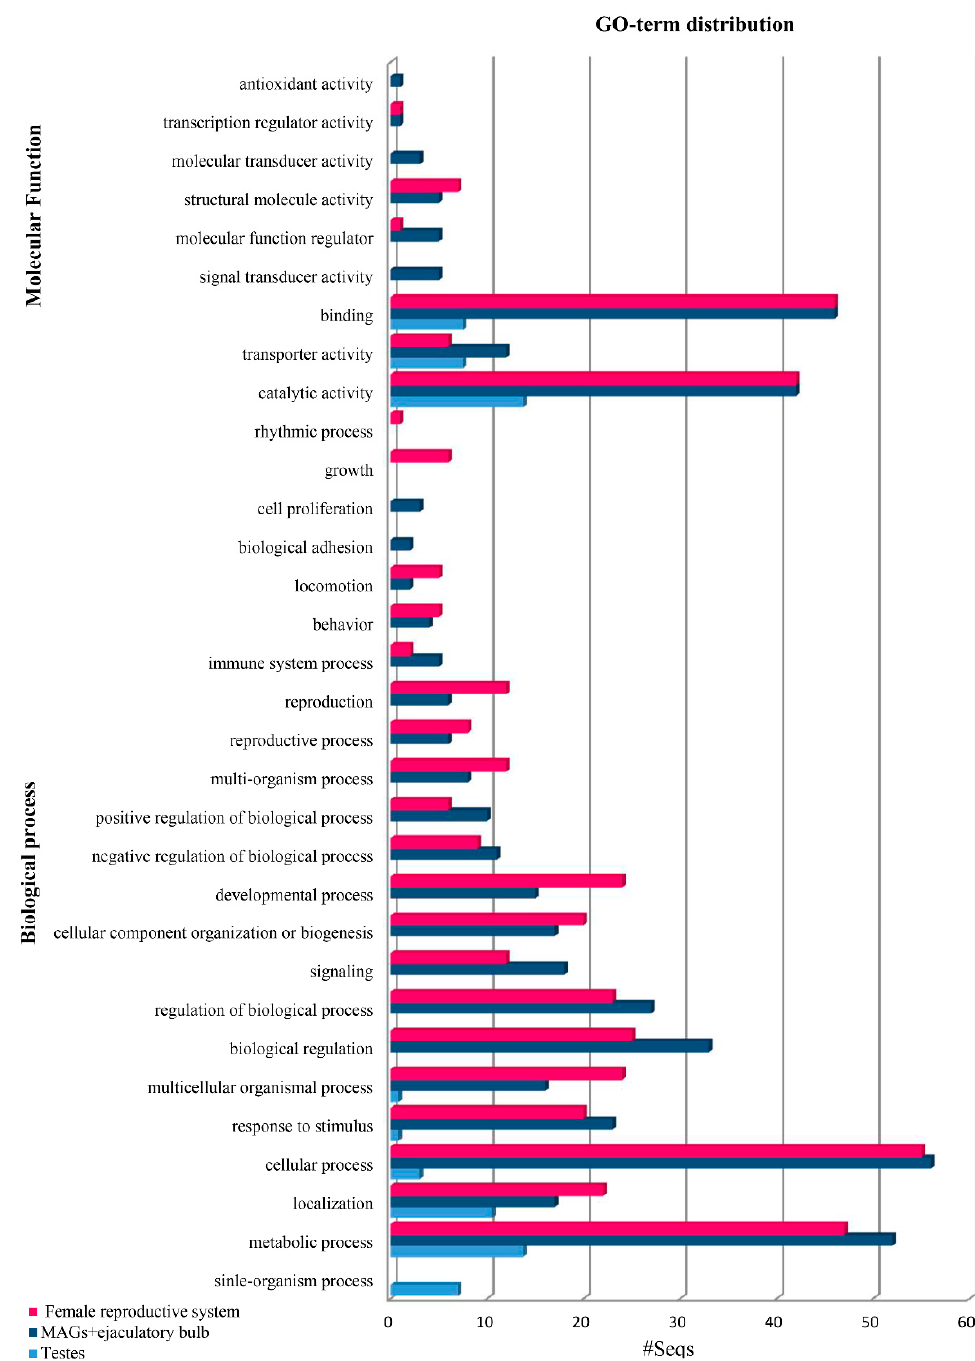
Figure 2. Gene Ontology (GO) terms (level 2) distribution of the top 100 overexpressed genes in Bactrocera oleae reproductive tissues from mated insects showing the top 20 hits of different categories for the molecular function (MF) and biological process (BP). Table 1. List of the differentially expressed genes of the RNAseq analysis selected for validation.